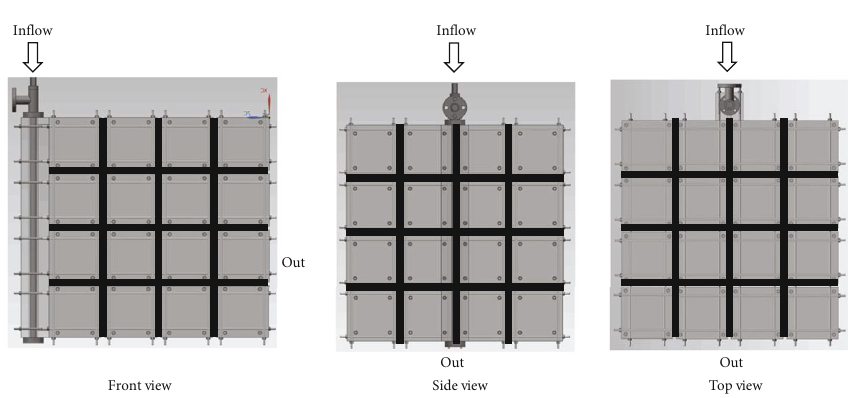
Figure 3: Schematic diagram of the complex fracture device design.